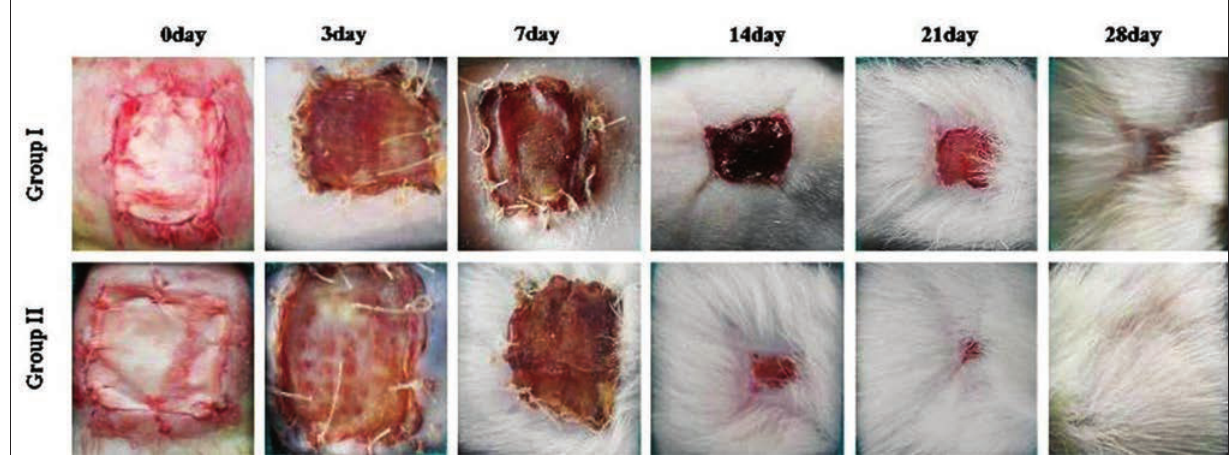
Figure-7: Macroscopic observations of healing at different time